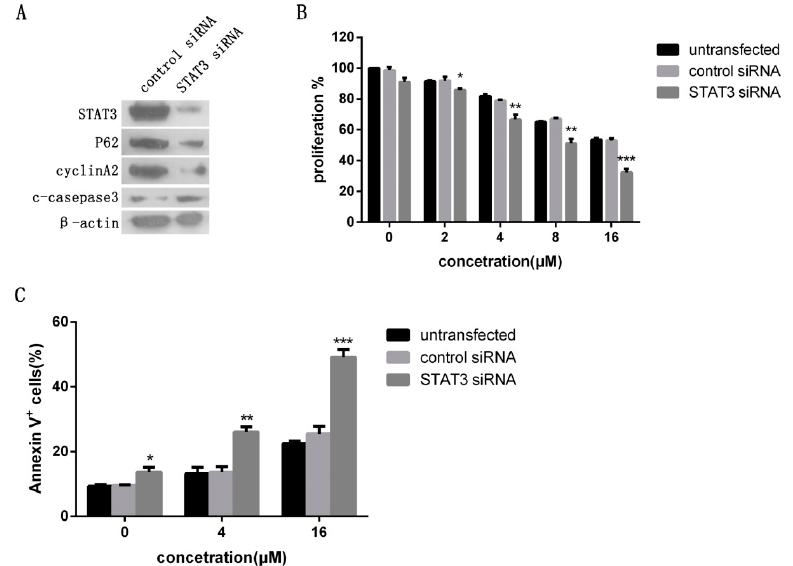
Figure 6. Antitumor effect of icaritin was affected by the levels of STAT3 activity in OSCC cells. ( A ) CAL27 cells were transfected with STAT3 and non-specific siRNA, and the successful transfection was confirmed by western blotting. STAT3 knockdown affected the expression of proliferation and apoptotic proteins; ( B , C ) STAT3 silencing enhanced the effects of icaritin on CAL27 cell growth inhibition and apoptosis promotion. CAL27 cells were transfected with either non-specific siRNA or STAT3 siRNA, and then treated with icaritin at the indicated doses for 48 h. Cell proliferation and apoptosis were detected. Data were expressed as mean ± SD ( n = 3, in triplicate). * p < 0.05; ** p < 0.01; and *** p < 0.001 versus 0 μ M